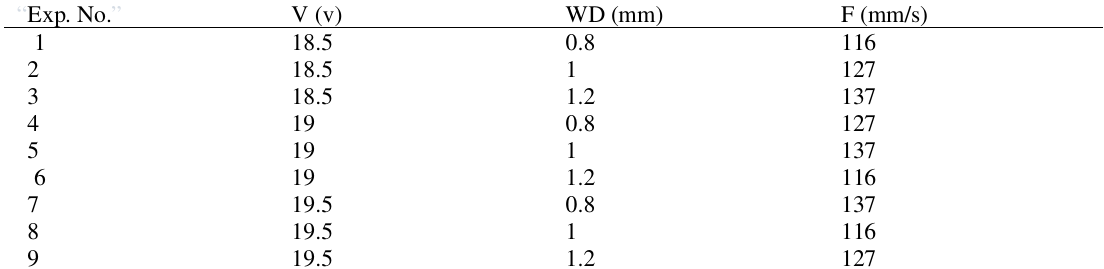
Input parameters and their levels by using DOE for this work. “Exp. No.”